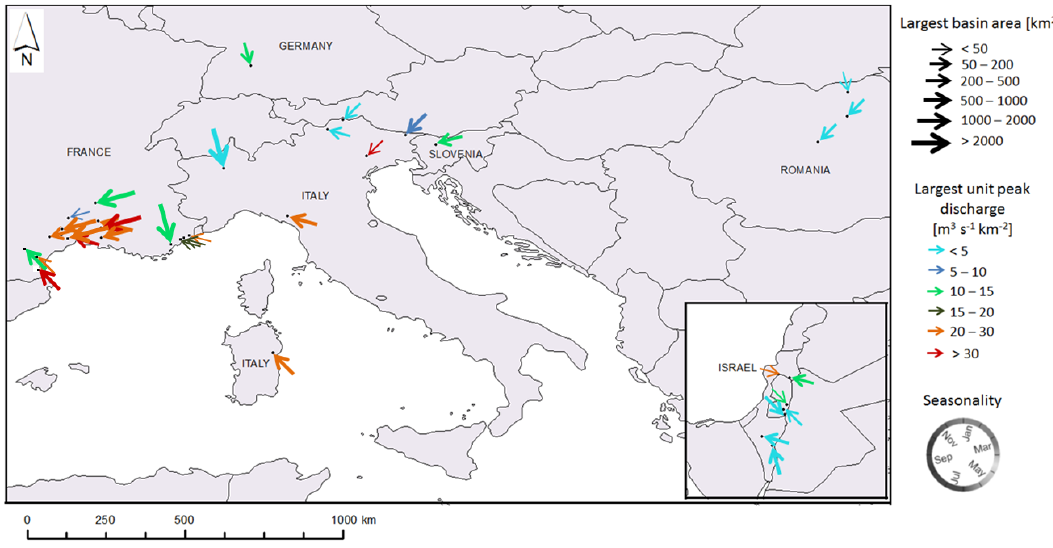
Figure 1. Location of the flash floods in the central and western Mediterranean, the Alps, and Inland Continental Europe; inset is the eastern Mediterranean (Israel). The length of the arrow represents the area of the largest basin. Colour indicates the magnitude of the largest unit peak discharge. Direction represents the timing of the flash flood occurrence.